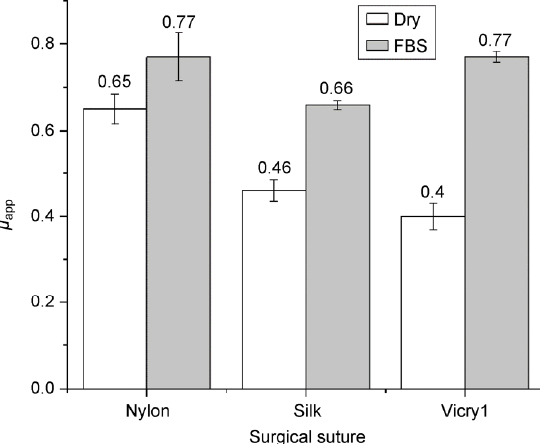
Fig. 8 Apparent coefficient of friction of silk, vicryl, and nylon at dry and the fetal bovine serum conditions under 0.10 N applied load, 15mm/s velocity.